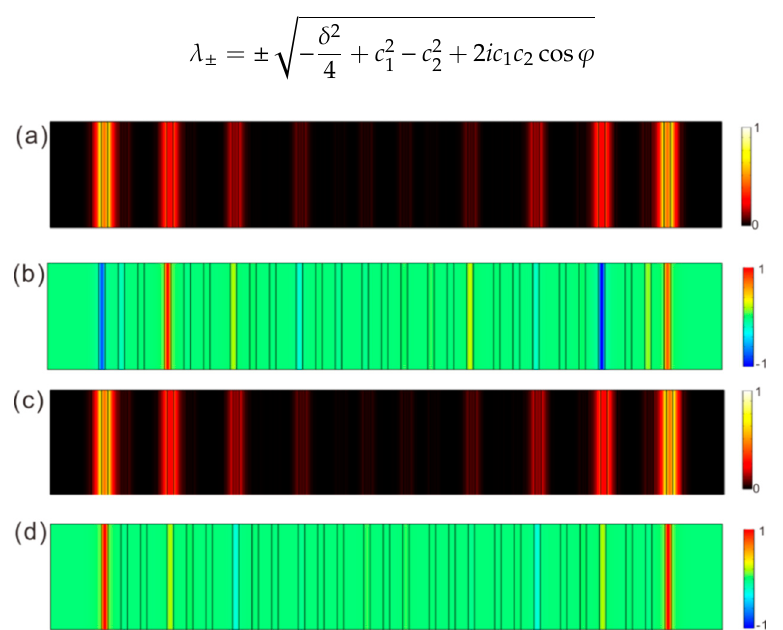
Figure 5. The field distributions of two edge modes. ( a ) and ( c ) are the norm of electric field ( | E | ) for two topological edge modes. ( b ) and ( d ) are the component of electric field along the x direction ( E x ).